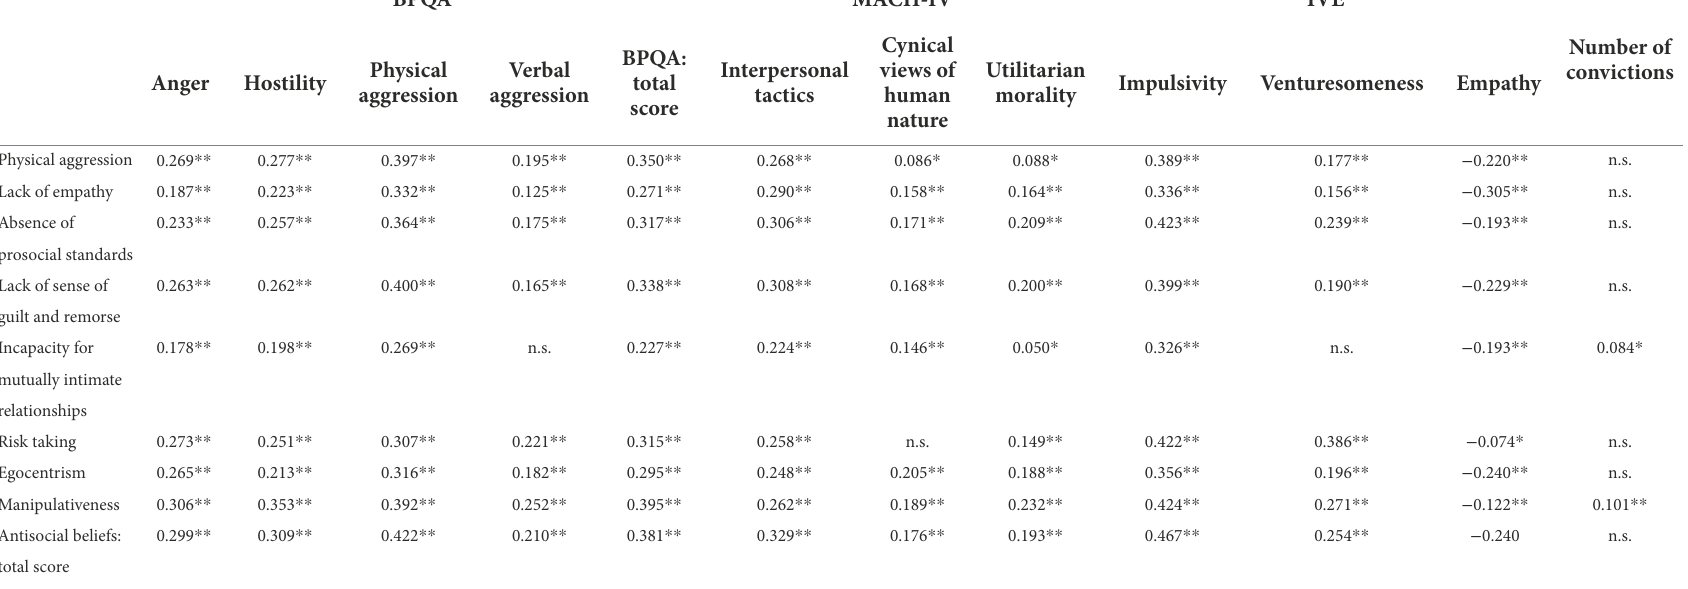
Number of convictions